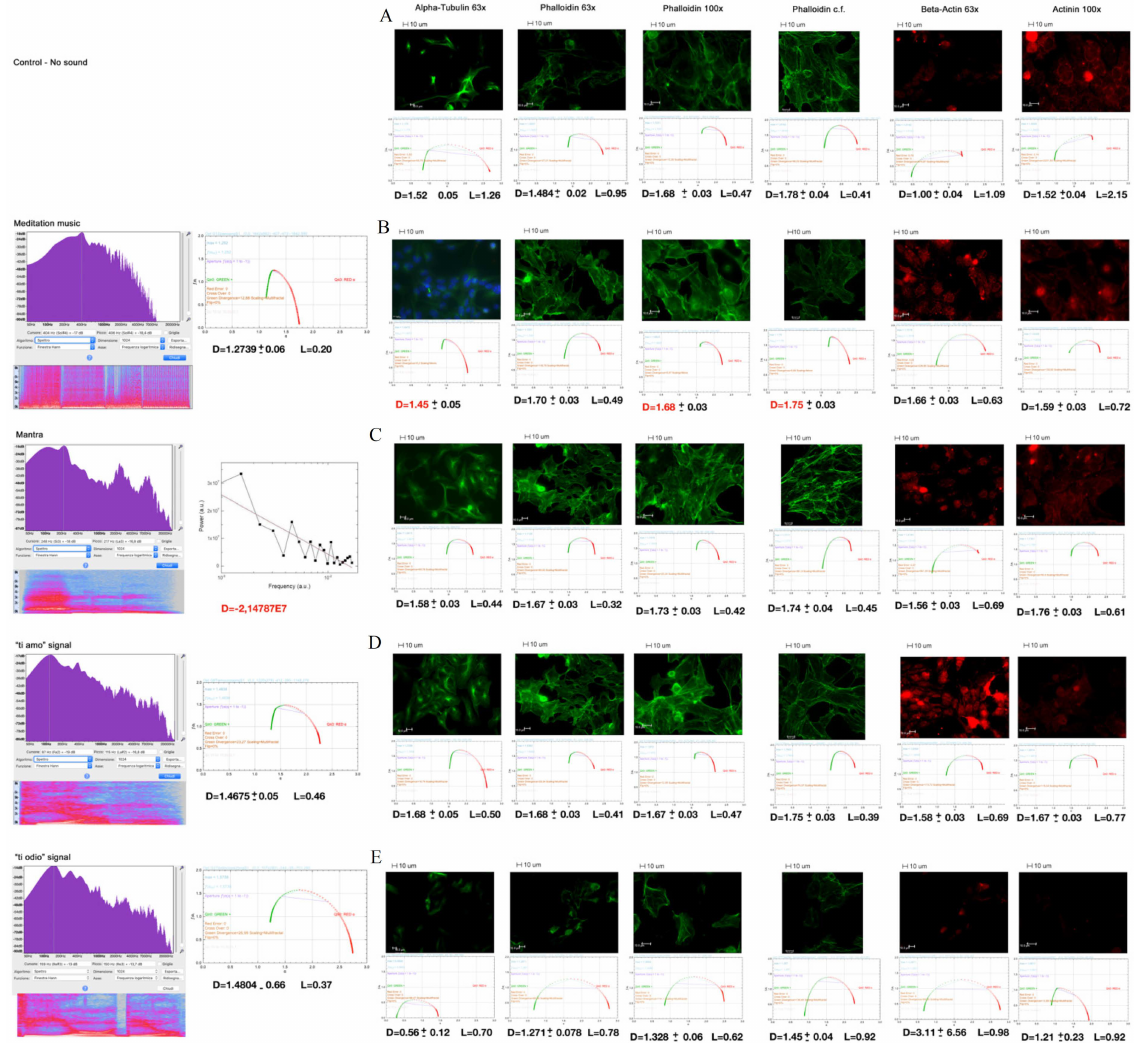
Figure 3. Sound analysis (left side of the panel) and the multifractal analysis of the immunofluorescent images of cytoskeletal markers (on the right). ( A ) Control cells, ( B ) Meditation music, ( C ) Mantra, ( D ) “ti amo” signal, ( E ) “ti odio” signal. On the left: the sound analysis (FFT on the top, underlying spectrum graphical depiction and spectral multifractal analysis next). On the right, in order: Alpha-tubulin 63 × (and Hoecst in B ), Phalloidin 63 × , 100 × , confocal (cf.), Beta-actin 63 × and Alpha-actinin-1 (Actinin) 100 × stainings after 20 min of each sound stimulation. Below a graph representing ƒ( α ) vs. α (the typical pattern for multifractals) and the results of the multifractal analysis reporting the average fractal dimension (D) and lacunarity (L) of all the experiments. All L parameters vary less than ± 0.002. All the photos are representative images selected from 5 positions and 6 experimental repetitions. Scale bar 10 µ